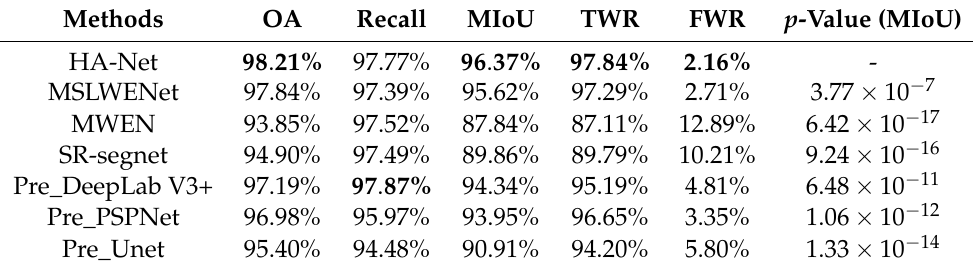
Table 3. The quantitative results of comparing the proposed method against other methods within the region of Figure 9.